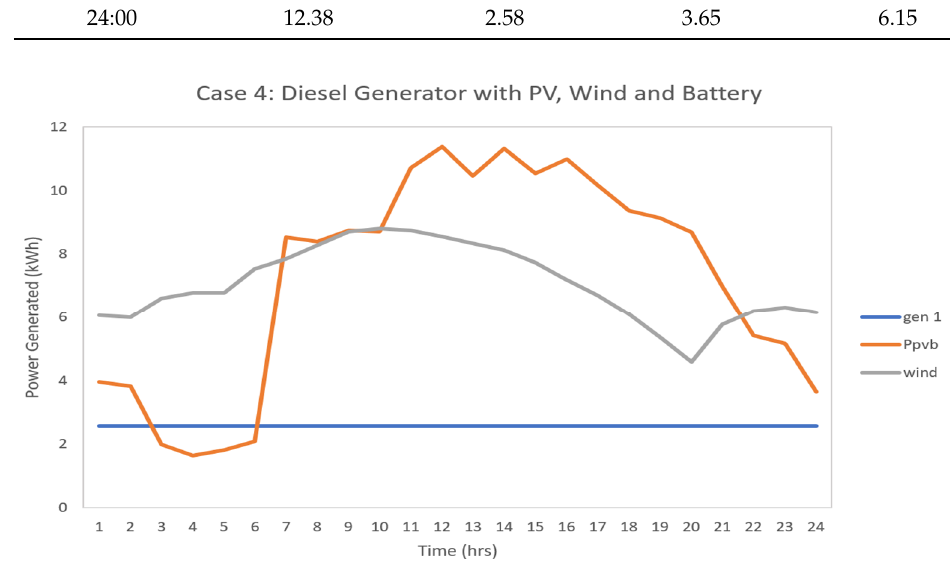
Figure 9. Case 4: Power output variation from diesel, PV and wind turbine generators.